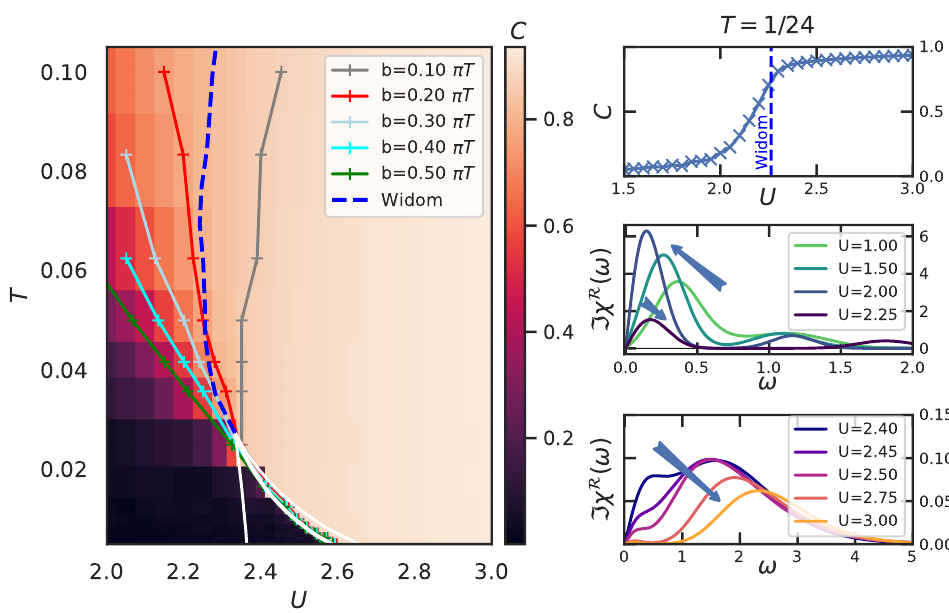
Figure 7: Left: Estimate of the anomalous term C ( T , U ) as a function of temperature and interaction strength over a broader portion of the DMFT phase diagram than the strict Mott MIT regime considered in Fig. 6. Data for the Widom line have been taken from [ 48 ] . The other colored curves mark the T and U values above which the QMC data are no longer compatible with only a (sharp) regular low-energy peak, consistent with a blurring of width b (see text). U , U and U curves taken from [ 29 ] . Right: c 1 c c 2 Evolution of the anomalous coefficient C (top panel) as well of the regular part of the absorption spectrum ℑ χ R ( ω ) (central and bottom panels) for increasing values of the interaction U at fixed temperature ( T = 1 / 24 (cid:39) 0.042 > T c